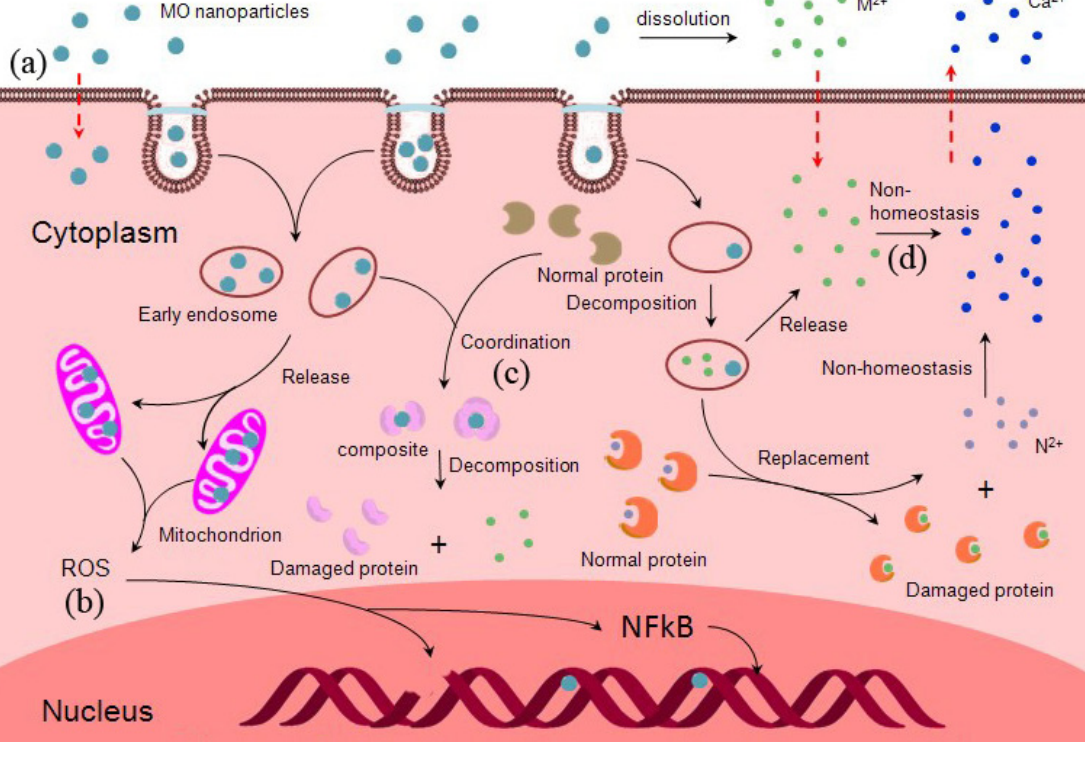
Figure 3. Schematic overview of the different pathways inducing cellular toxicity by CuO and ZnO NPs. (a) Potential mechanisms of CuO and ZnO NPs’ entry into cells; (b) The ROS effect of intracellular CuO and ZnO NPs; (c) The coordination effect of Cu 2+ and Zn 2+ released from NPs in cell; (d) The non-homeostasis effect disrupted by Cu 2+ and Zn 2+